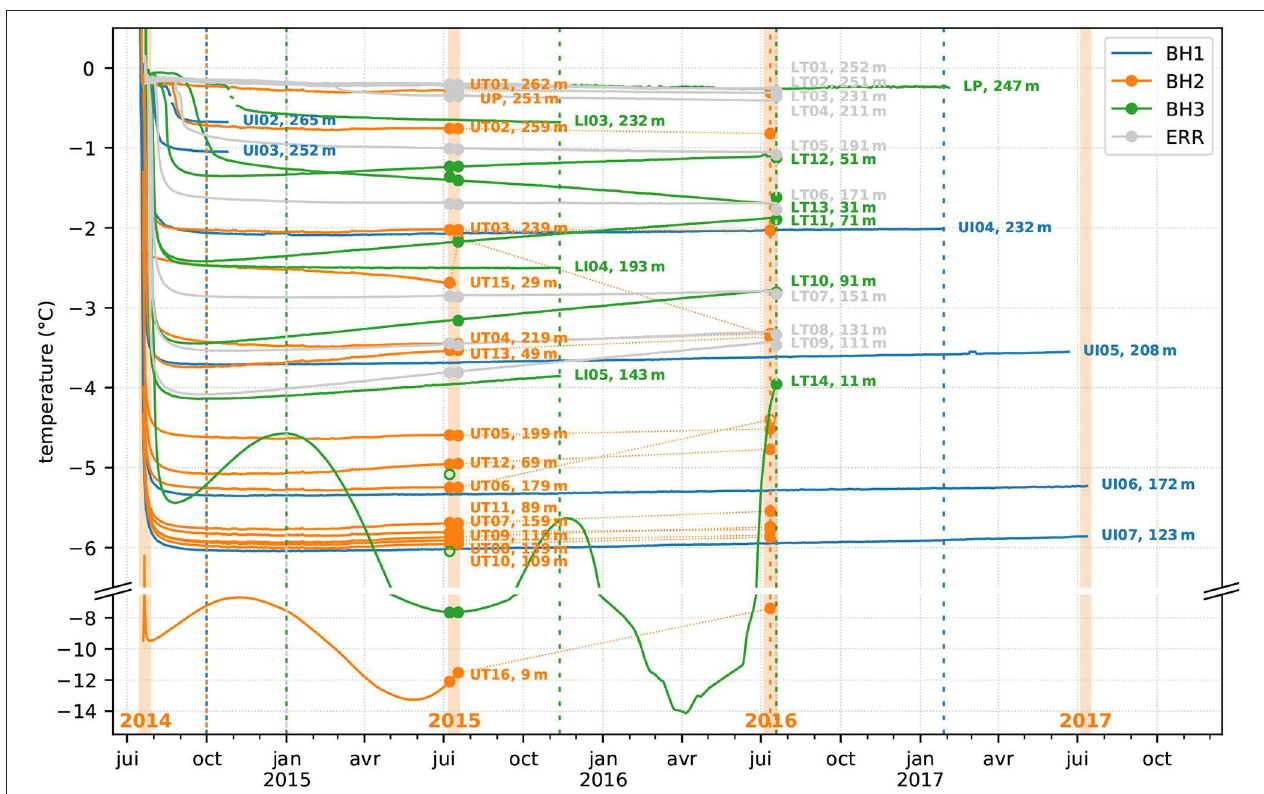
FIGURE 3 | Ice temperature time series from the three boreholes (BH1, BH2, and BH3) including BH3 erratic data (ERR, see text) from the drilling in July 2014 to the last data retrieval in July 2017, and manual temperature readings (circles, with outliers marked as empty circles, and 2017 values off the graph). Field campaigns (verical orange spans) and the dates selected for temperature profiles (vertical dashed lines; Figure 4 ) are